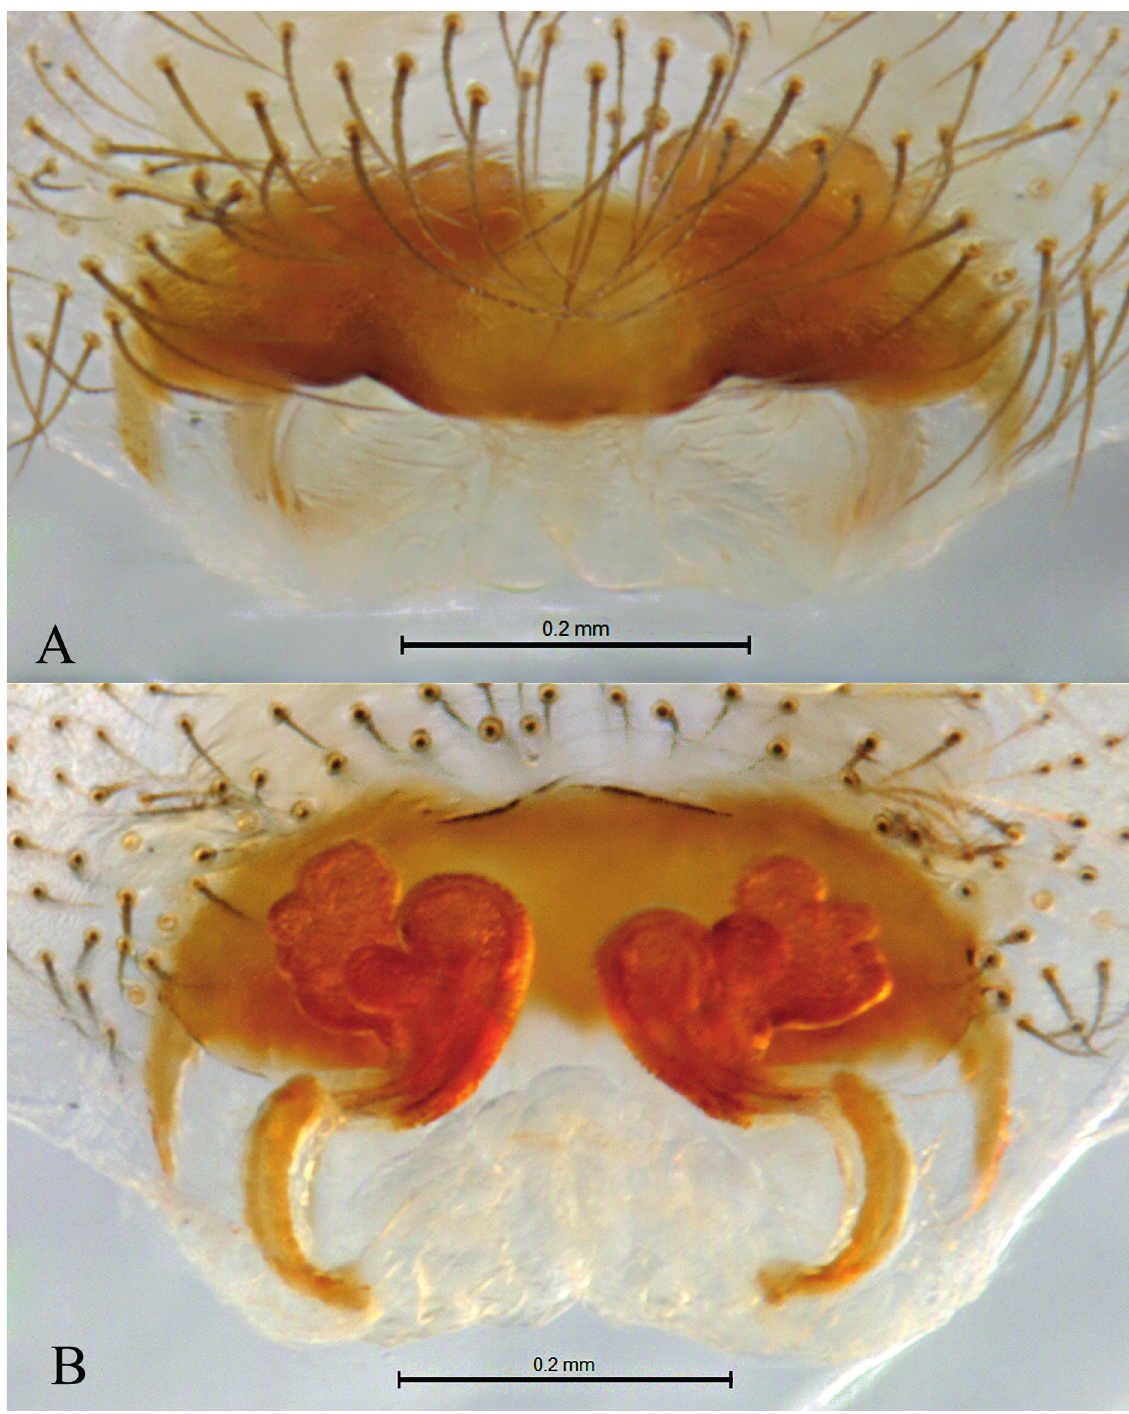
Fig. 18. Meta wanglang sp. nov., ♀, paratype (SWUC-T-TEg-07-03). A . Epigyne, ventral view. B . Vulva, dorsal